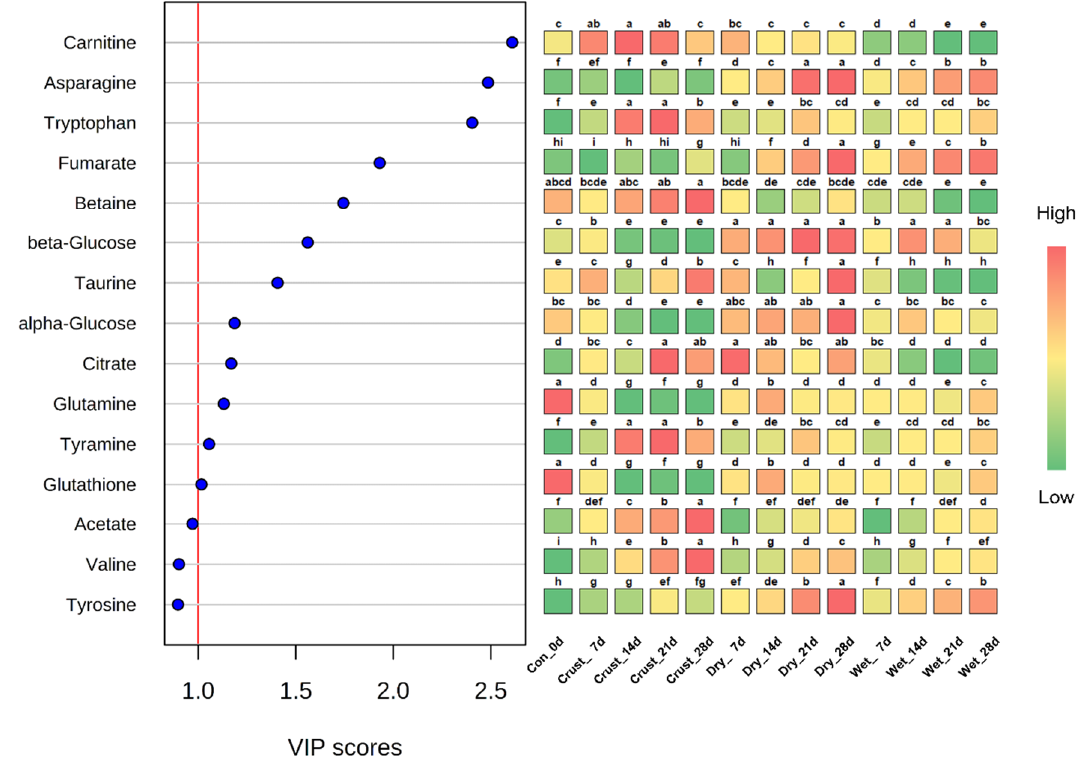
Figure 2. Variable importance in projection (VIP) scores of partial least squares-discriminant analysis (PLS-DA) from the extracts of crust, dry-aged, and wet-aged beef. The colored boxes on the right indicate the relative concentrations of the corresponding metabolites (red, high; yellow, intermediate; green, low). a-i Letters different in the same row indicate a significant difference ( p < 0.05).